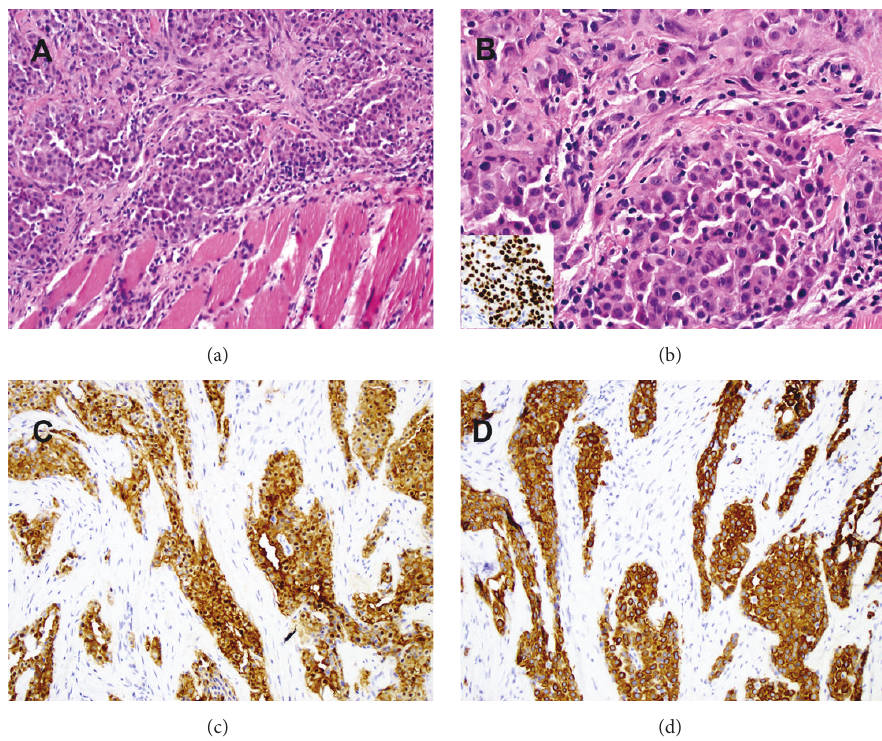
Figure 2: Histopathology and immunoprofile of the metastatic malignant mesothelioma to the breast. ((a) and (b)) Representative H&E captions from the metastatic malignant mesothelioma in the breast biopsy which show proliferation of neoplastic epithelioid cells forming cords and nests which infiltrate the breast parenchyma and skeletal muscles. The neoplastic cells are round to polygonal with moderate cytoplasm, moderate cytologic pleomorphism, and occasional nucleoli. The neoplastic cells are positive for WT1 (inset in (b)), calretinin (c), and CK5/6